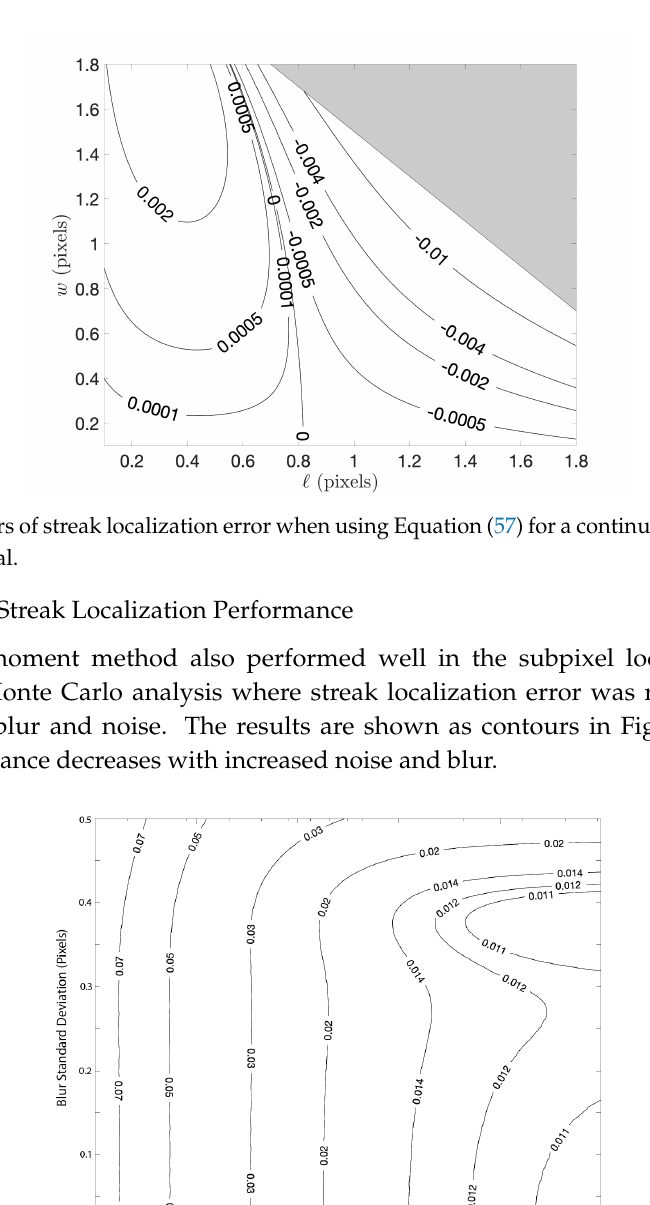
5 mask) in a digital image for ×